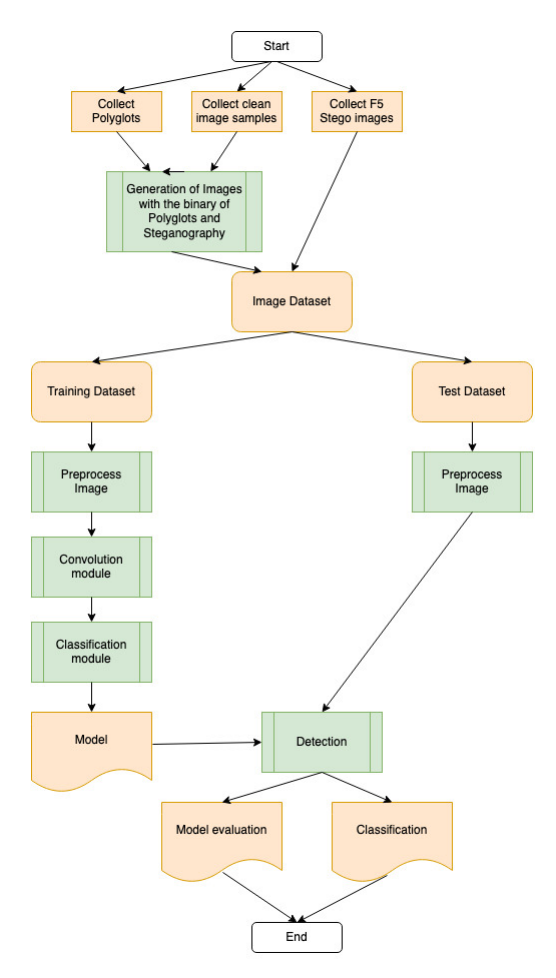
Figure 1. Framework of Blind